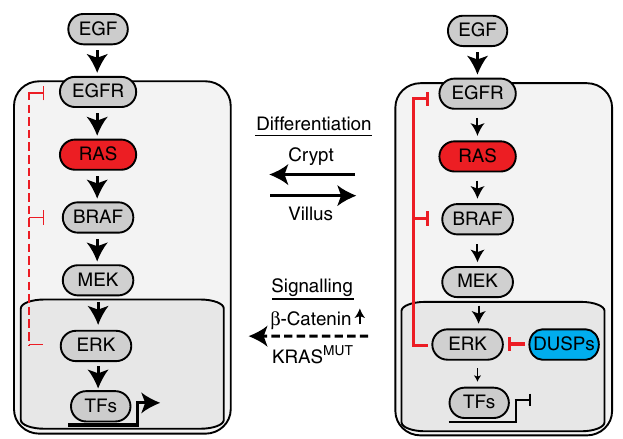
Fig. 8 Model of cell type-speci fi c regulation of ERK activity. ERK is regulated cell type-speci fi c and cell-intrinsic via different strengths of feedback inhibition and feed-forward signalling from MEK to ERK. Dual-speci fi city phosphatases (DUSPs) are important regulators of ERK activity. β -catenin and KRAS G12V activities modulate cell fate decisions towards the generation of cells with high ERK activity, likely in part due to low expression of genes encoding